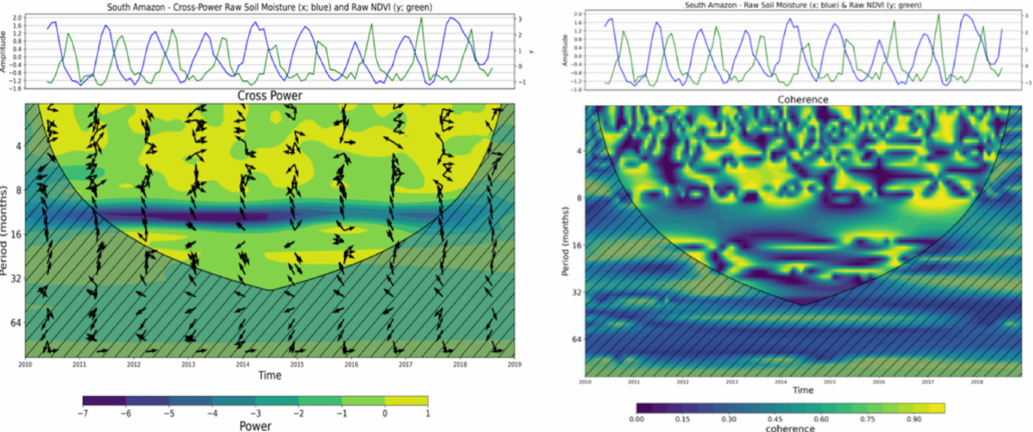
Figure 6. Wavelet cross-spectra (WCS, left panel) and wavelet coherency analyses (WCO, right panels) for the SA region. Arrows pointing to the right in the WCS panels denote that both series are in phase, whereas pointing to the left denote that both series are out of phase. The linear color scale for the WCO results go from deep blue (WCO = 0) to yellow (WCO =